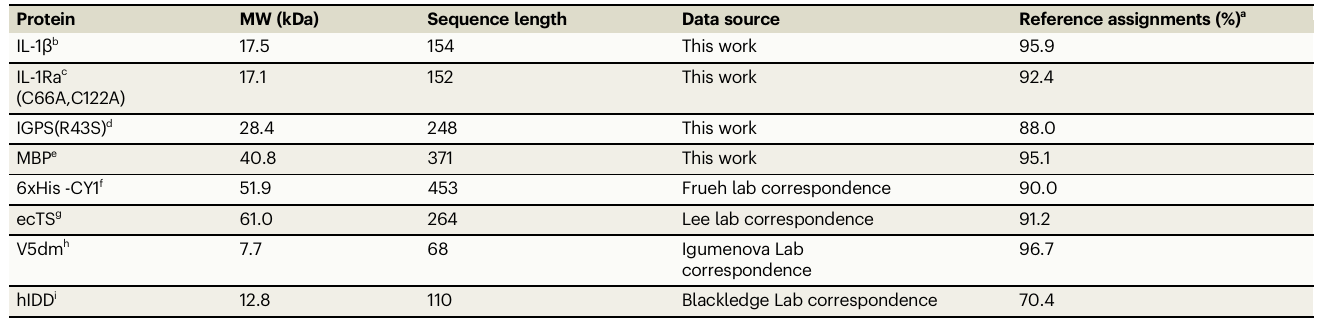
Supplementary Table 3). Reference structure: PDB9ILB. c Deposited to BMRBunderaccession code 51352. Reference structure: PDB 2IRT.